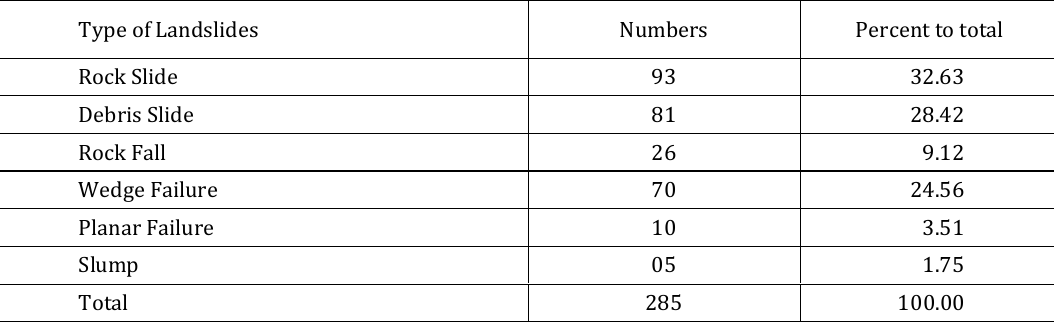
Table 1. Types of landslides (compiled by Author based on Geological Survey of India) Type of